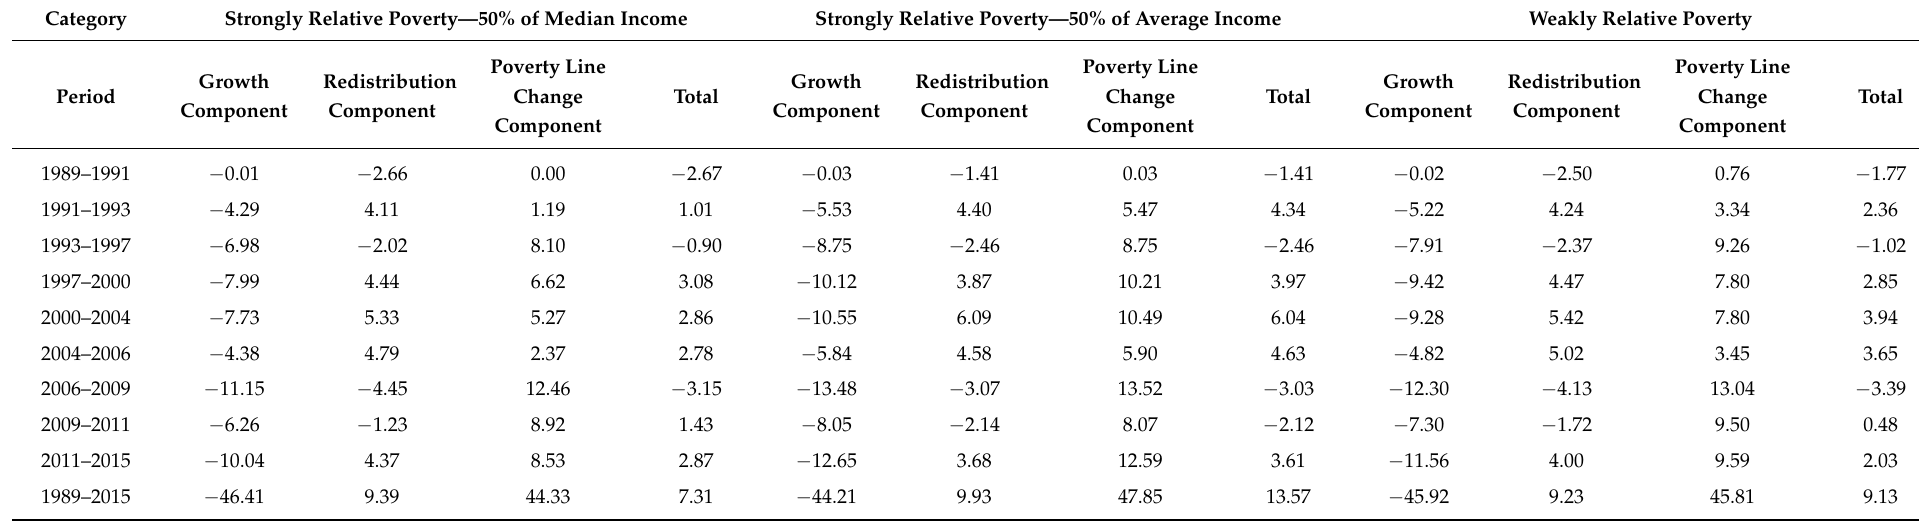
Table 6. Decomposition of the change in the national relative poverty incidence